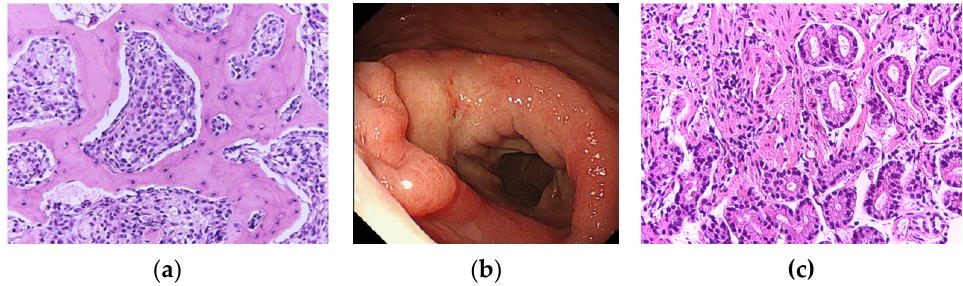
Figure 4. Pathological image of the bone lesion in the tissue collected by biopsy and endoscopic/ pathological images of the upper gastrointestinal region. ( a ) Proliferation of a signet ring, poorly differentiated tumor was detected in the inter-trabecular area (hematoxylin-eosin staining, ×100). ( b ) Abnormal reddish mucosa was observed around the anastomotic site. The biopsy specimens were collected from the slightly protuberant wall. ( c ) The pathological image from the biopsy. There was a similar proliferation of poorly differentiated tumor cells (hematoxylin-eosin staining, ×100). Treatment consisted of administration of antitumor compounds (tegafur + gimeracil + oteracil potassium, [TS-1], 50 mg, bis in die) and subcutaneous injection of denosumab markers and tumor biomarkers had decreased (ALP, 52 U/L; P1NP, 35 ng/mL;